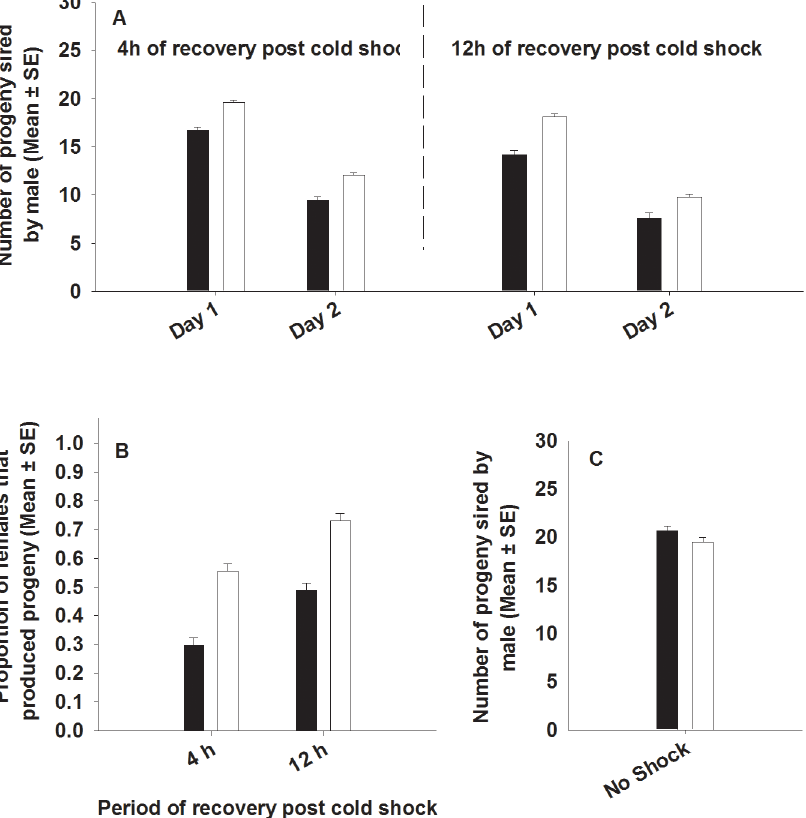
Fig 5. Effect of cold shock (A and B) or no shock (C) on progeny production . Closed bars represent FCB and open bars represent FSB populations. (A) Number of progeny produced by (ancestral) BRB females exposed to FSB or FCB males subjected to cold shock and allowed to recover for 4 or 12 hours. Selection and day had significant effect on the progeny production. (B) The proportion of ancestral females which had produced progeny after being exposed to FSB or FCB males that were cold shocked and allowed to recover for 4 or 12 hours. Selection and period had significant effect on the proportion of females that produce zero progeny after being exposed to cold shocked male. However, two way interaction of selection × period was not significant. (C) Under no shock treatment, there was no significant difference in the number of progeny sired by FSB and FCB males when exposed to ancestral BRB